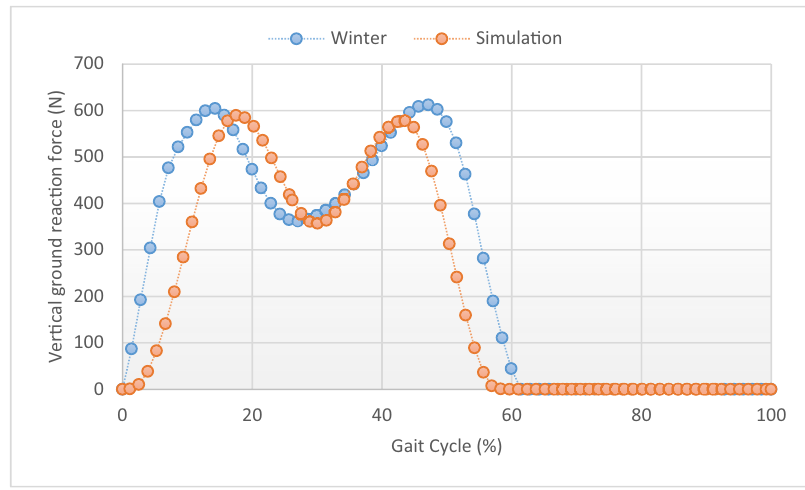
Figure 27: Comparison between model and healthy leg: VGRV vs gait cycle.